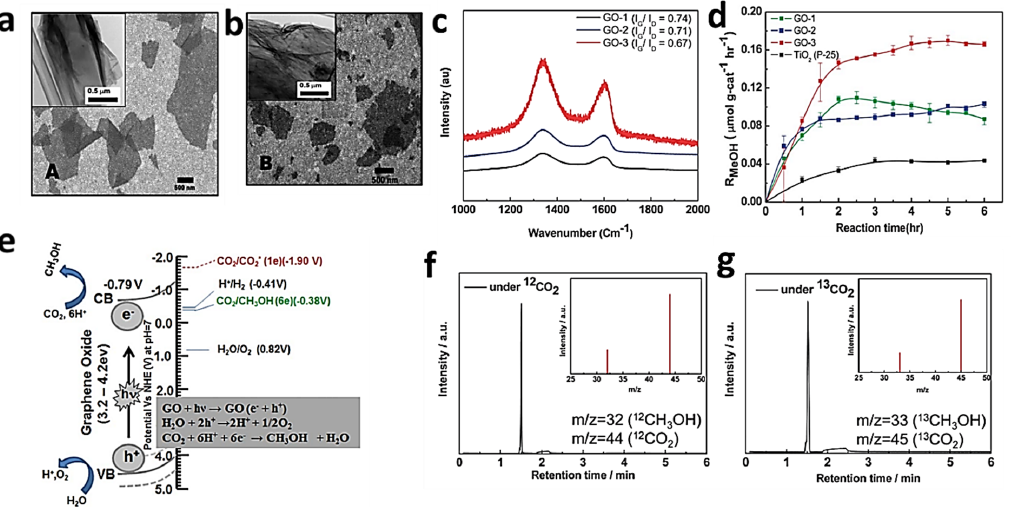
Figure 23. ( a , b ) SEM images of GO sheets on gold substrate. ( c ) Raman spectra for three different GO sheets, ( d ) photocatalytic methanol formation (RMeOH) on various GO sheets and TiO 2 using simulated source of solar-light, ( e ) schematics showing the photocatalytic CO 2 reduction mechanism on GO sheets, ( f , g ) MS chromatograms and profiles of methanol produced by photocatalytic reduction of 13 CO 2 or 12 CO 2 with 0.2 g GO-2 with ( f ) MS chromatogram at m / z 32 in 12 CO 2 and ( g ) MS chromatogram at m / z 33 in 13 CO 2 . Reproduced with the permission from